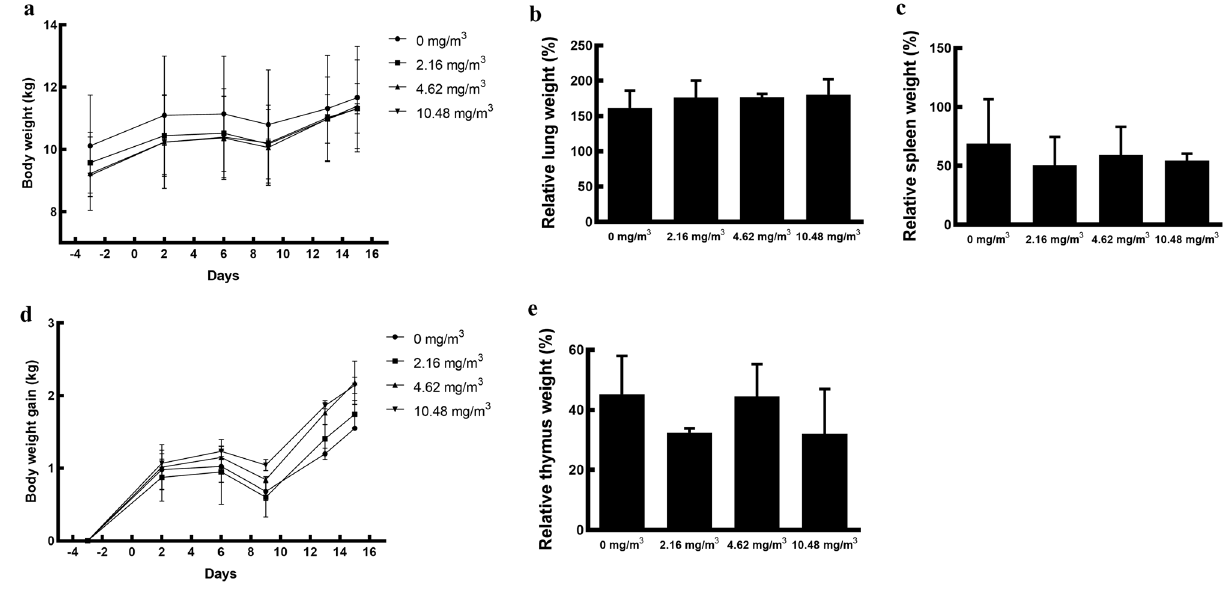
Figure 1. Body and organ weights in Yucatan minipigs. Changes in body weight ( a ) and weight gain ( d ) of minipigs exposed to FA. Relative weights of organs, including the lung ( b ), spleen ( c ), and thymus ( e ) were calculated. Data are presented as the mean ± SD ( n = 2 minipigs/group). FA formaldehyde.